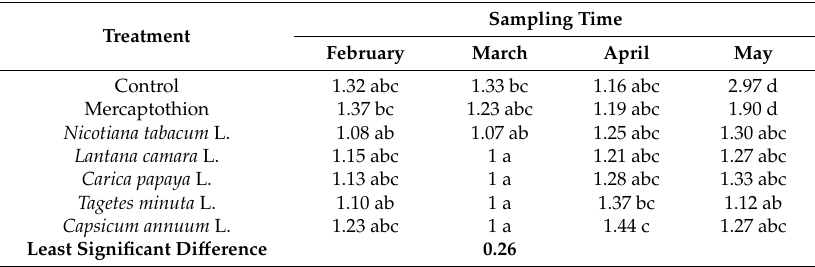
Table 5. Okra leaf damage across sampling times.